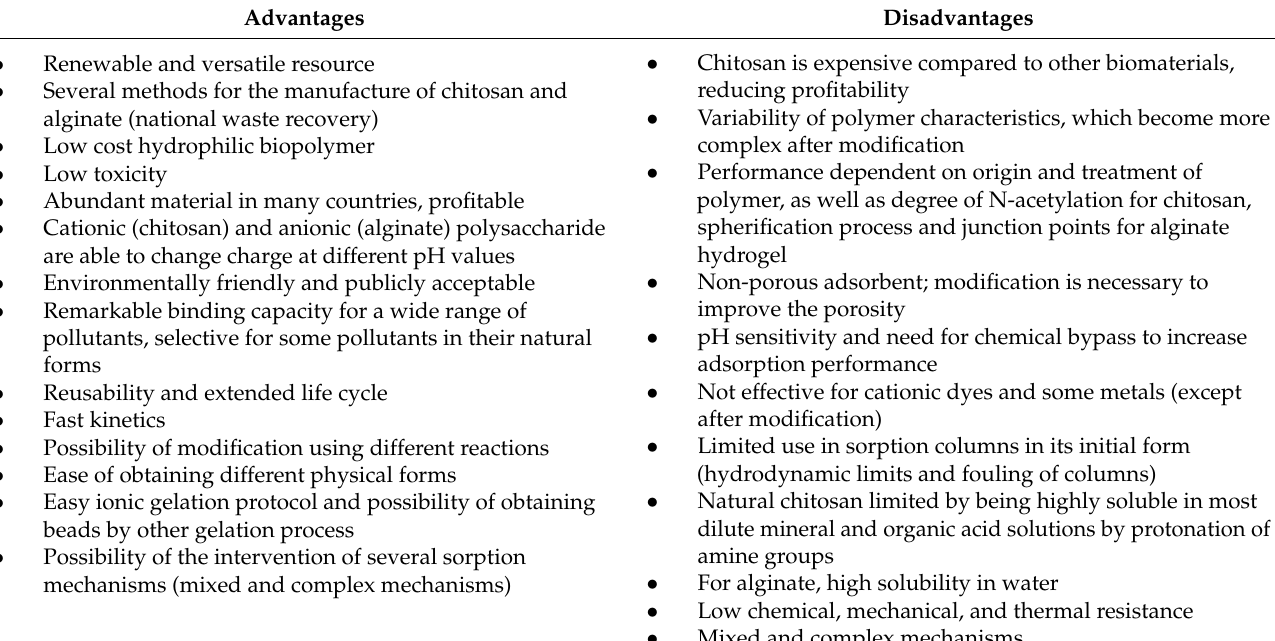
Table 1. Some advantages and disadvantages of applying bio-adsorbents based on chitosan and alginate to eliminate hazardous pollutants from aqueous